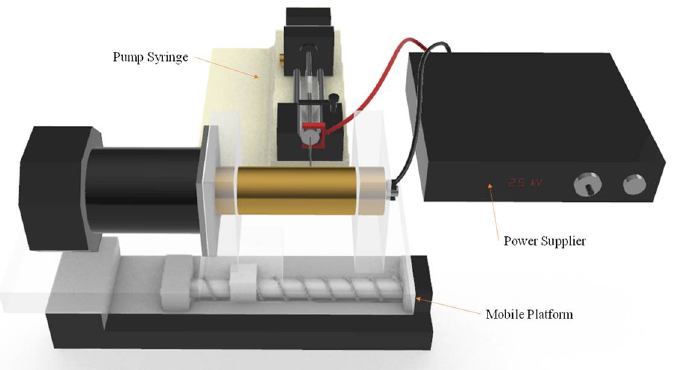
Figure 2. Schematic diagram of near-field electrospinning (NFES)